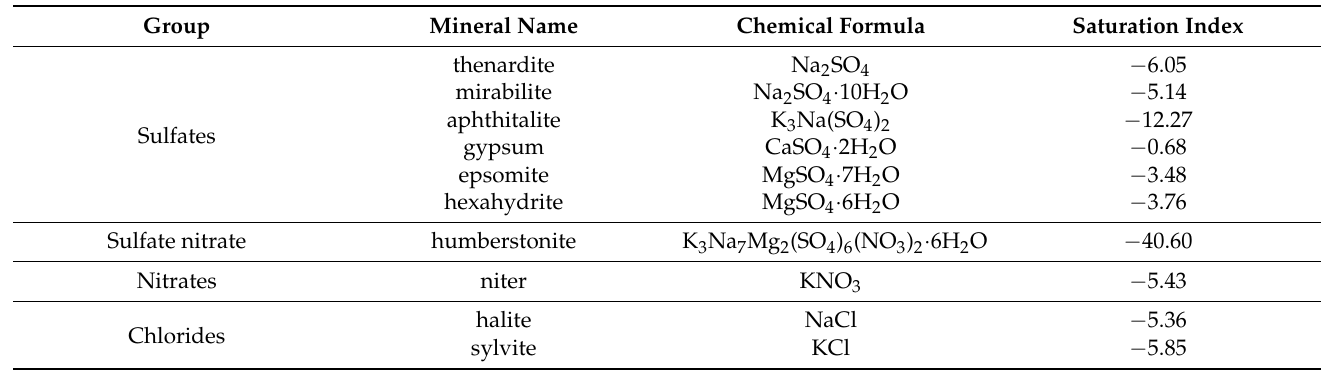
Table 2. Group, mineral name, and chemical formula of salts found in the monument. Saturation index of the studied minerals for the groundwater is calculated at 25 ◦